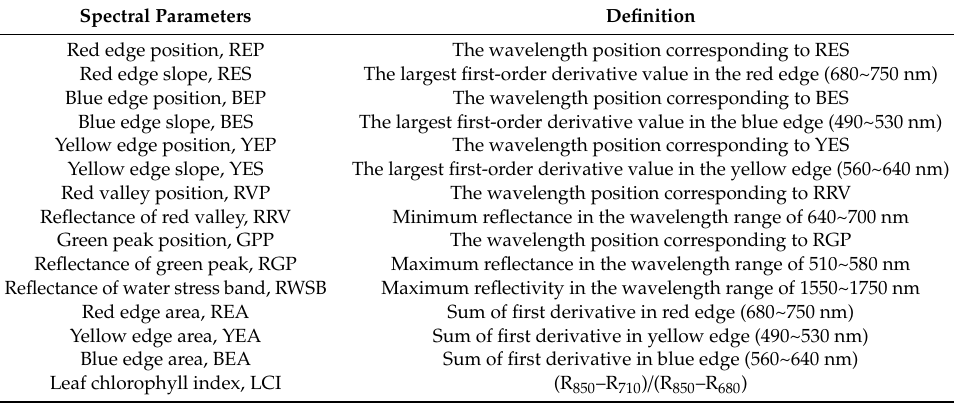
Table 1. Description of spectral parameters.